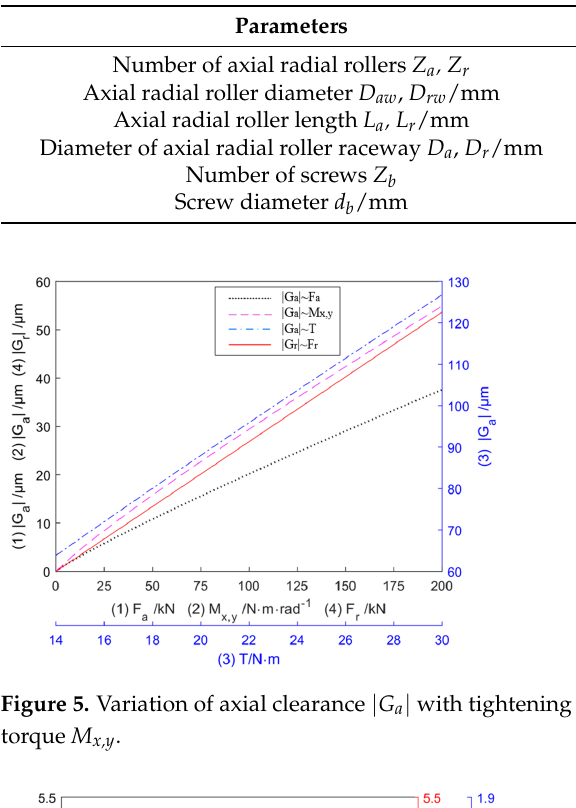
Table 1. Initial parameters of the turntable bearing.